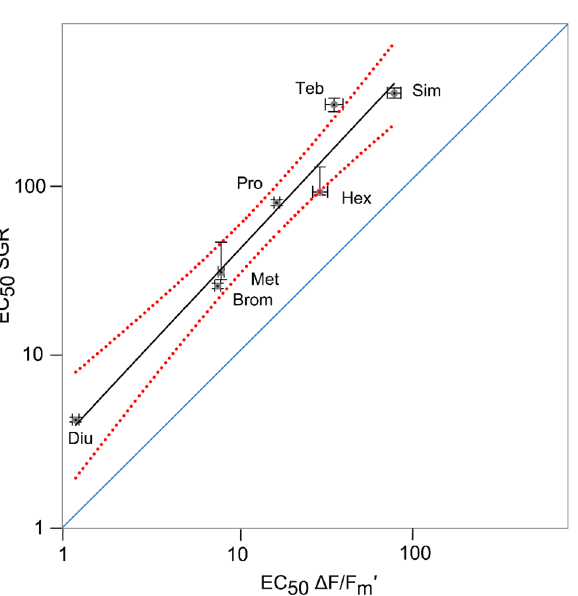
Figure 3. Response of Cladocopium goreaui to alternative non-PSII herbicides, haloxyfop and imazapic. Boxplots of the specific growth rate (SGR day −1 ) and effective quantum yields (ΔF/F m ′ ) in response to haloxyfop ( a , c ) and imazapic ( b , d ). Note: all concentrations here are in mg L −1 .